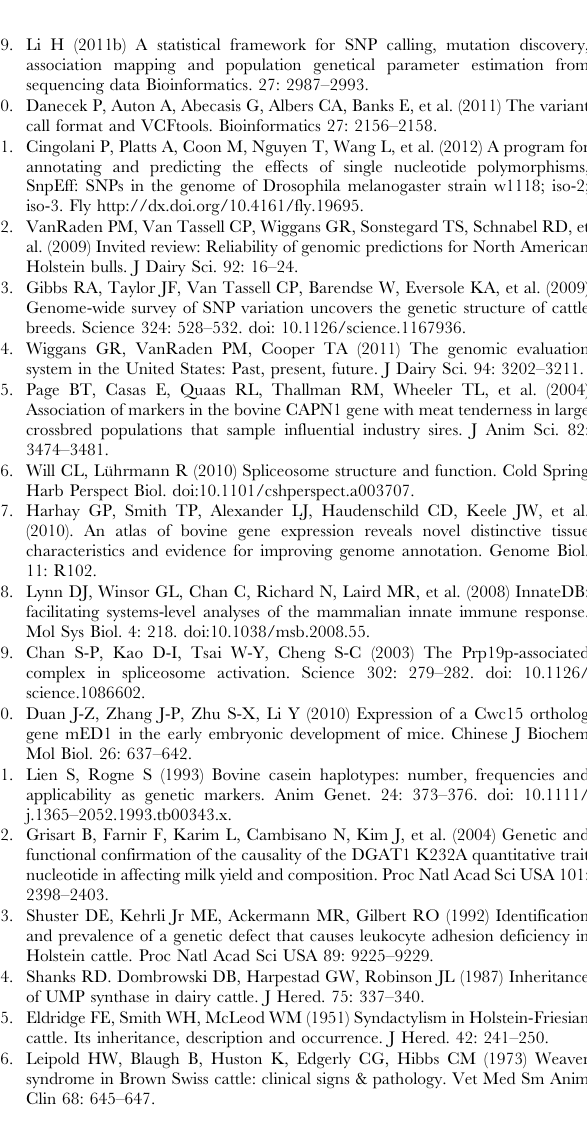
Figure S2 The expected decrease in conception rate for noncarrier 6 noncarrier matings as a function of misidentification rate and carrler frequency Table S1 The 15 SNP in the refined JH1 interval region used to design a Sequenom validation test. (PDF) Text S1 The effect of pedigree error rates and carrier allele frequencies on the observed reduction in conception